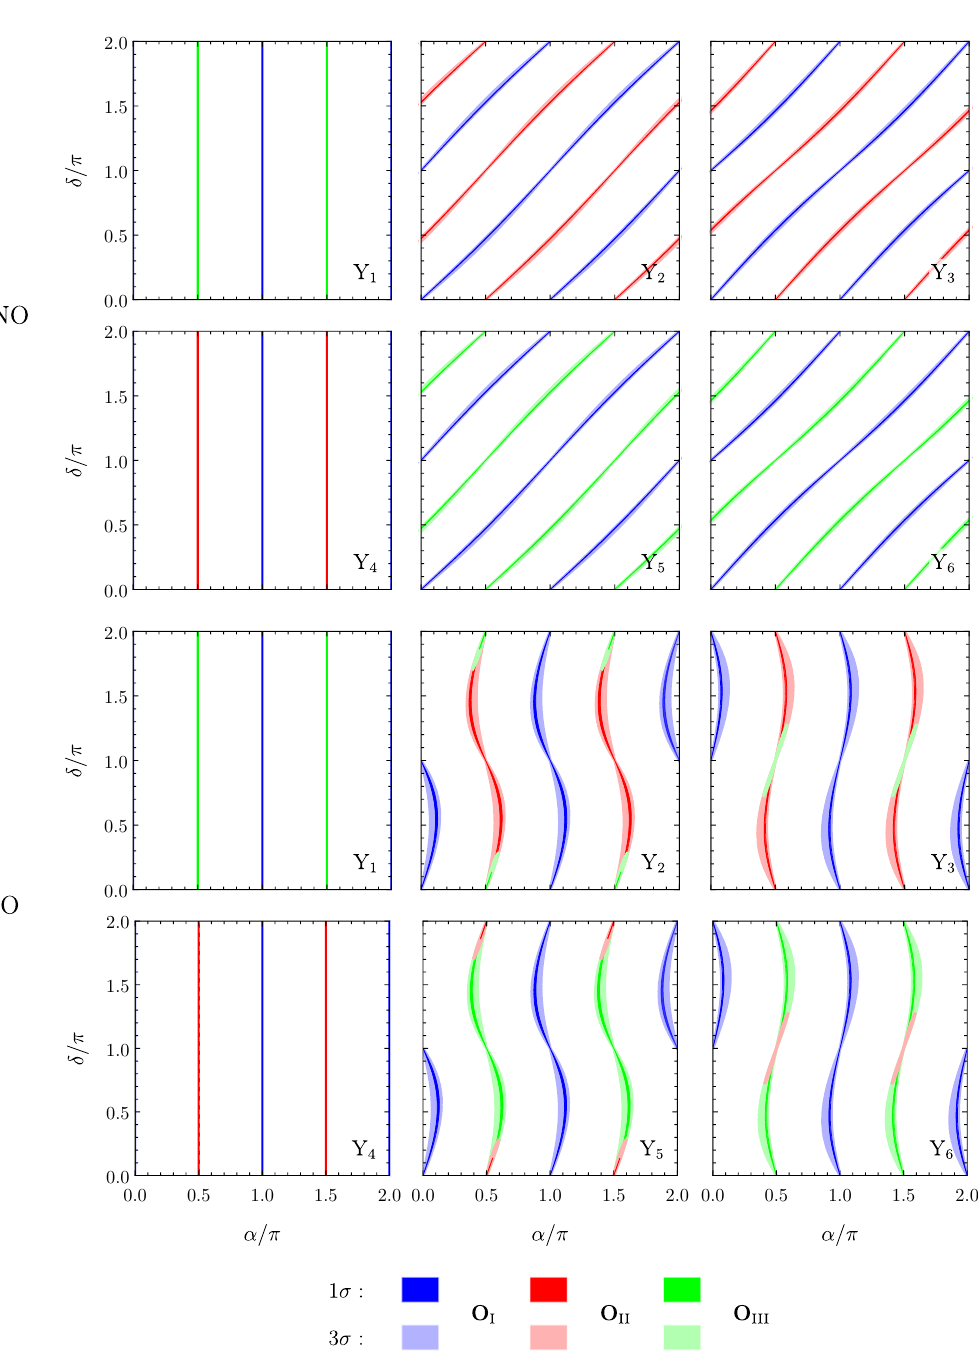
Figure 1 . Allowed regions in the ( (cid:11) , (cid:14) ) plane for all (R 1 ,Y 1 (cid:0) 6 ) combinations, both for NO (upper plots) and IO (lower plots). The light (dark) coloured regions were obtained varying (cid:18) ij and (cid:1) m 2 within the 3 (cid:27) (1 (cid:27) ) experimental ranges given in table 1. In blue, red and green we show the results for the cases in which O is of the type O I , O II and O III , respectively.